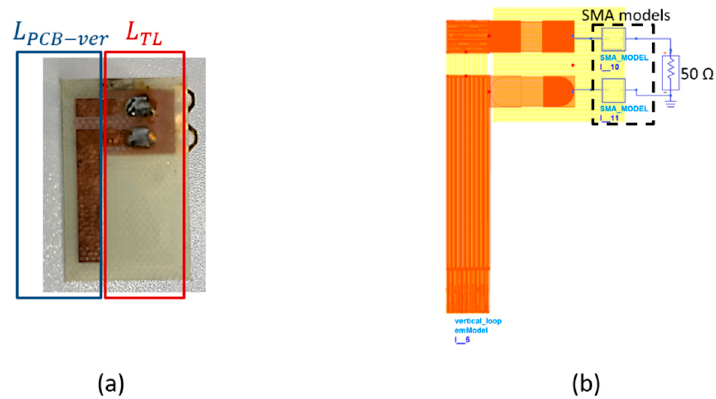
Figure 19. Vertical PCB loop: ( a ) test fixture; ( b ) simulation setup.